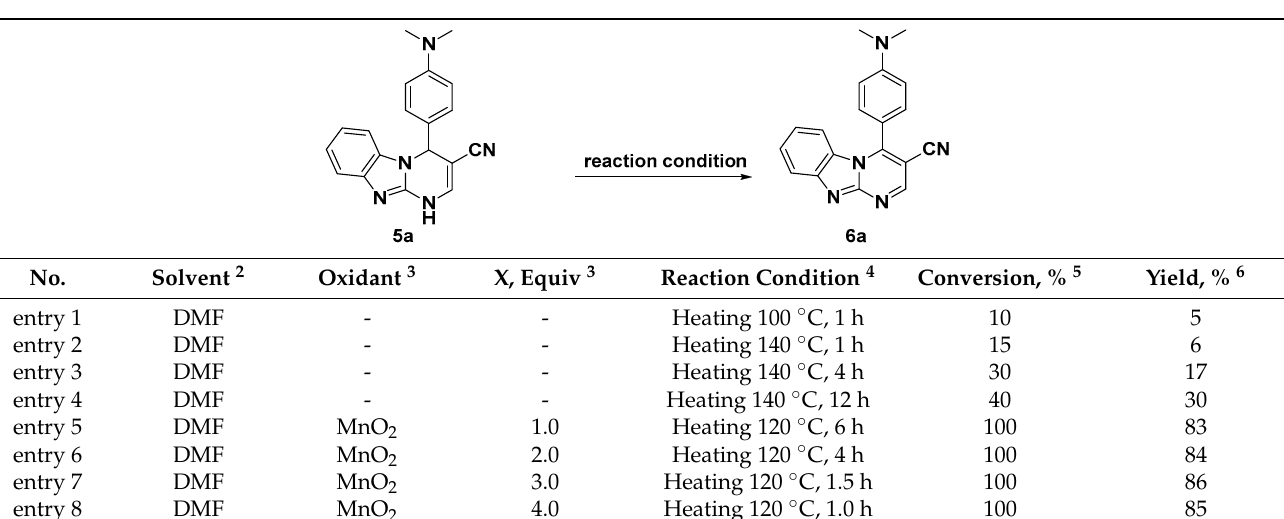
Table 2. Optimization of the oxidation reactions for dihydropyrimidin 5a 1 .